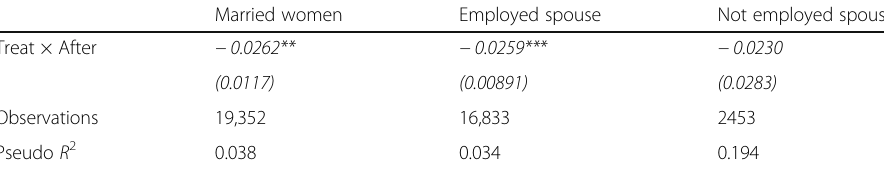
Table 6 Effect of AUH on the probability of entering the labor force. Heterogeneities: spouse ’ s labor condition Married women Employed spouse Not employed spouse Treat × After Observations